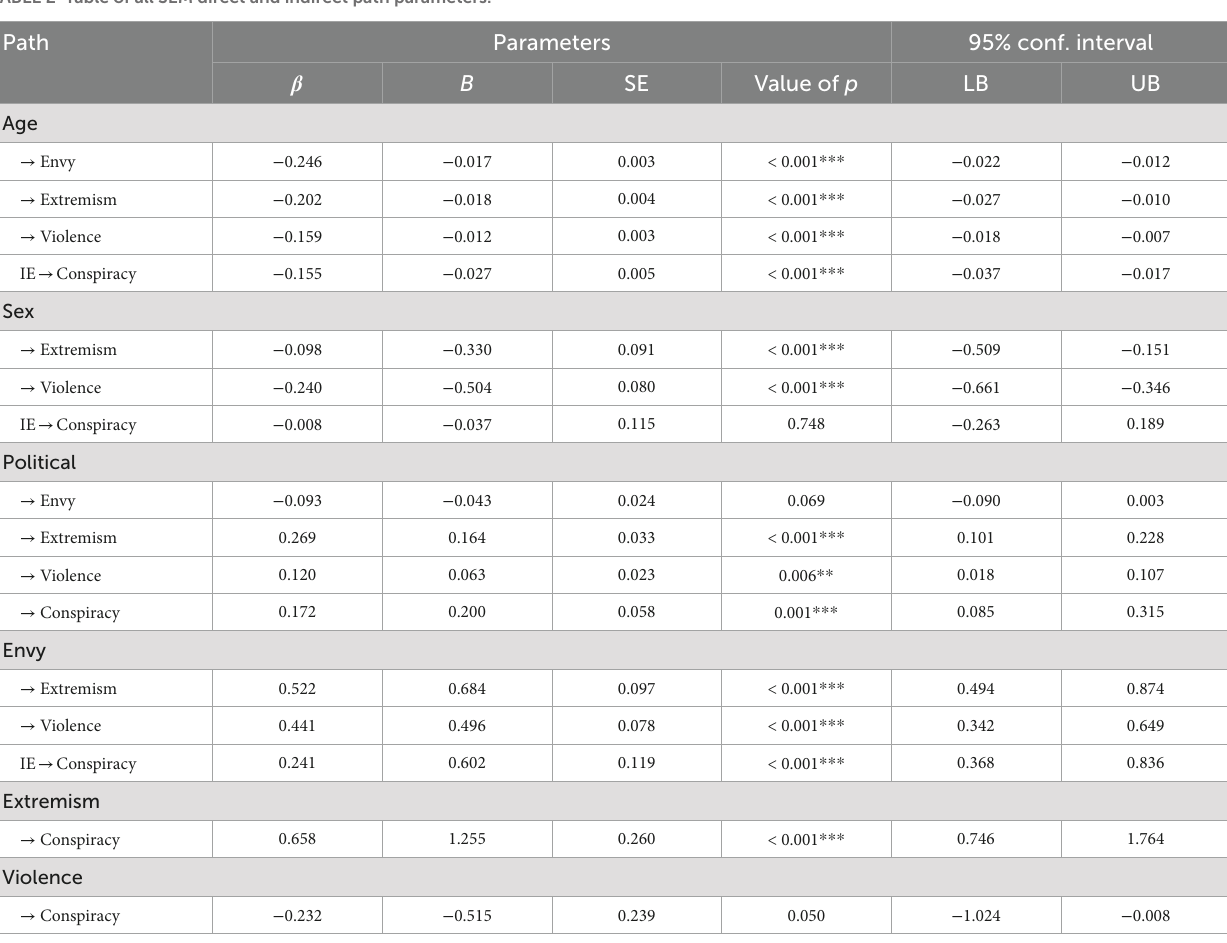
TABLE 2 Table of all SEM direct and indirect path